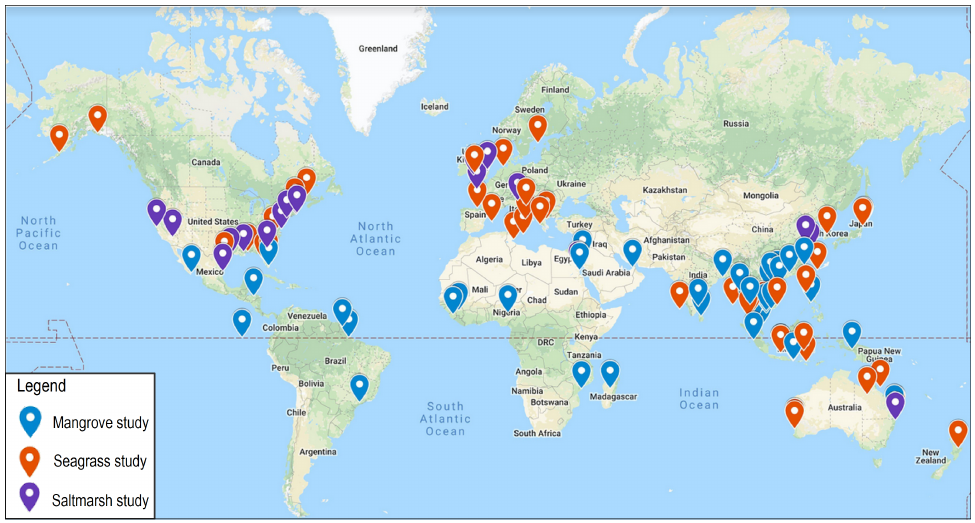
Figure 4. The review of the study sites. Table 1. Summary of remote sensing data used for mangroves, seagrasses, and salt marshes. HS, high spatial resolution; MS, medium/low spatial